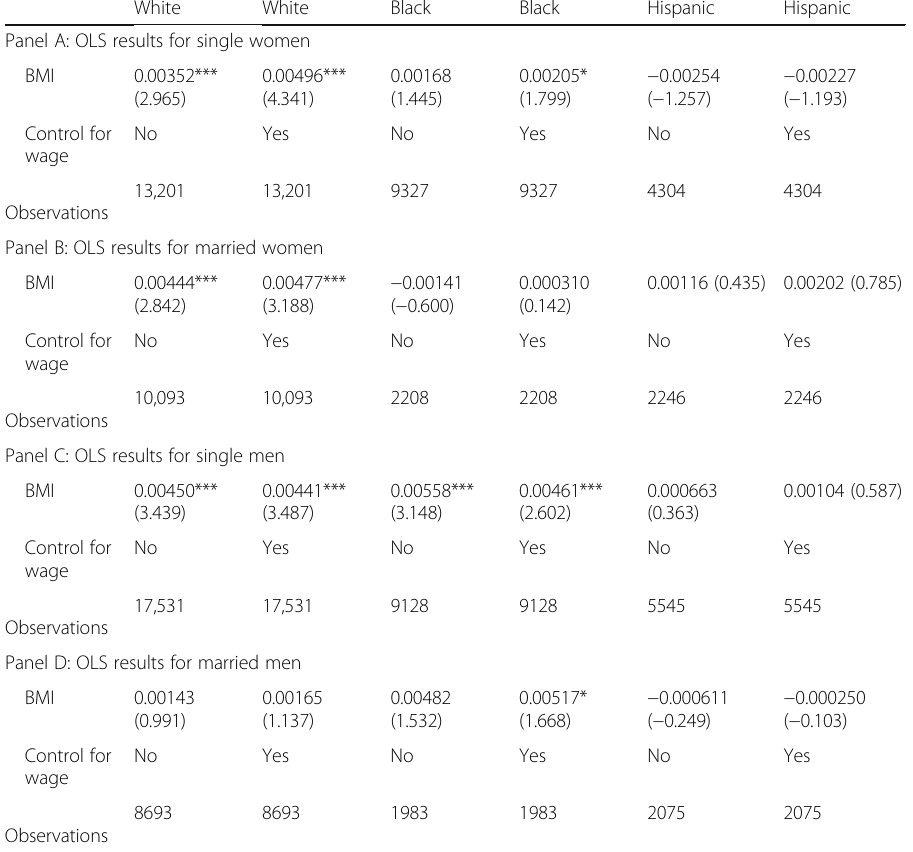
Single Married OLS IV Sibling FE OLS Panel A: BMI Winsorized at 1% of BMI distribution, our baseline BMI Panel B: BMI 17.2 – 45.5 BMI Panel C: BMI 18.5 – 40.0